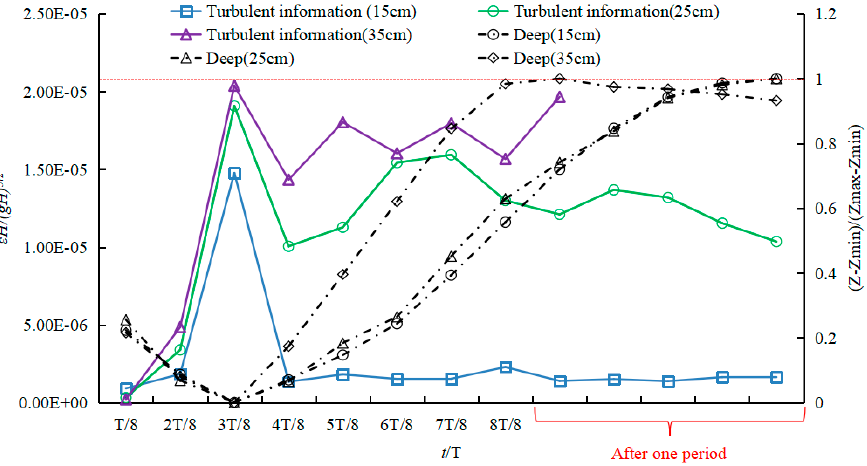
Figure 19. Relationship between turbulent dissipation rate and submergence depth under breaking waves.